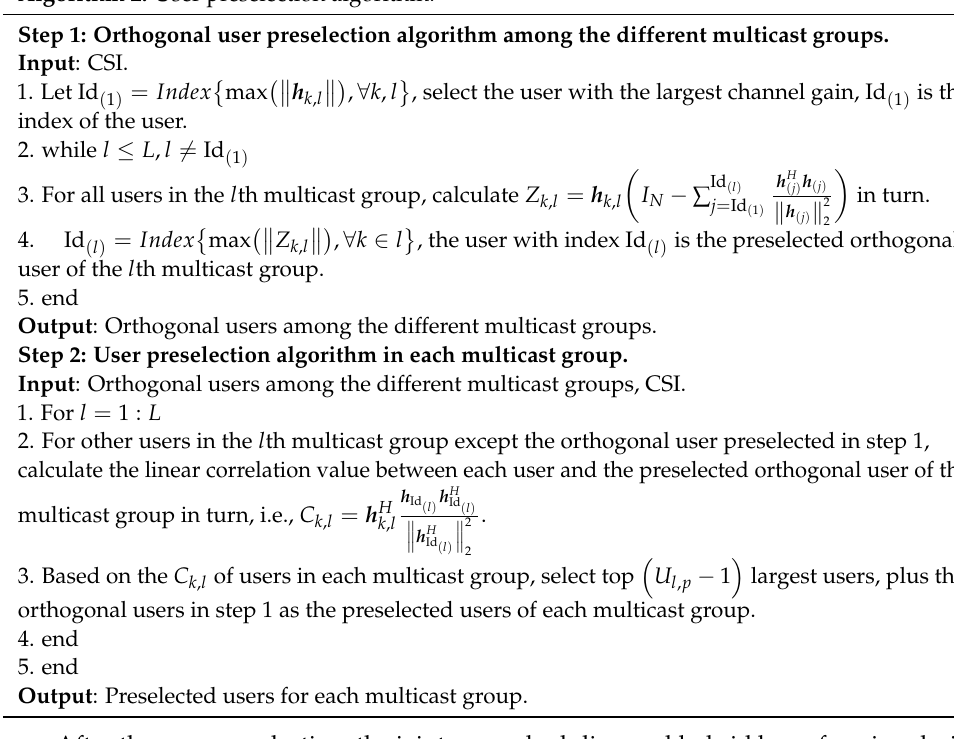
Algorithm 2: User preselection